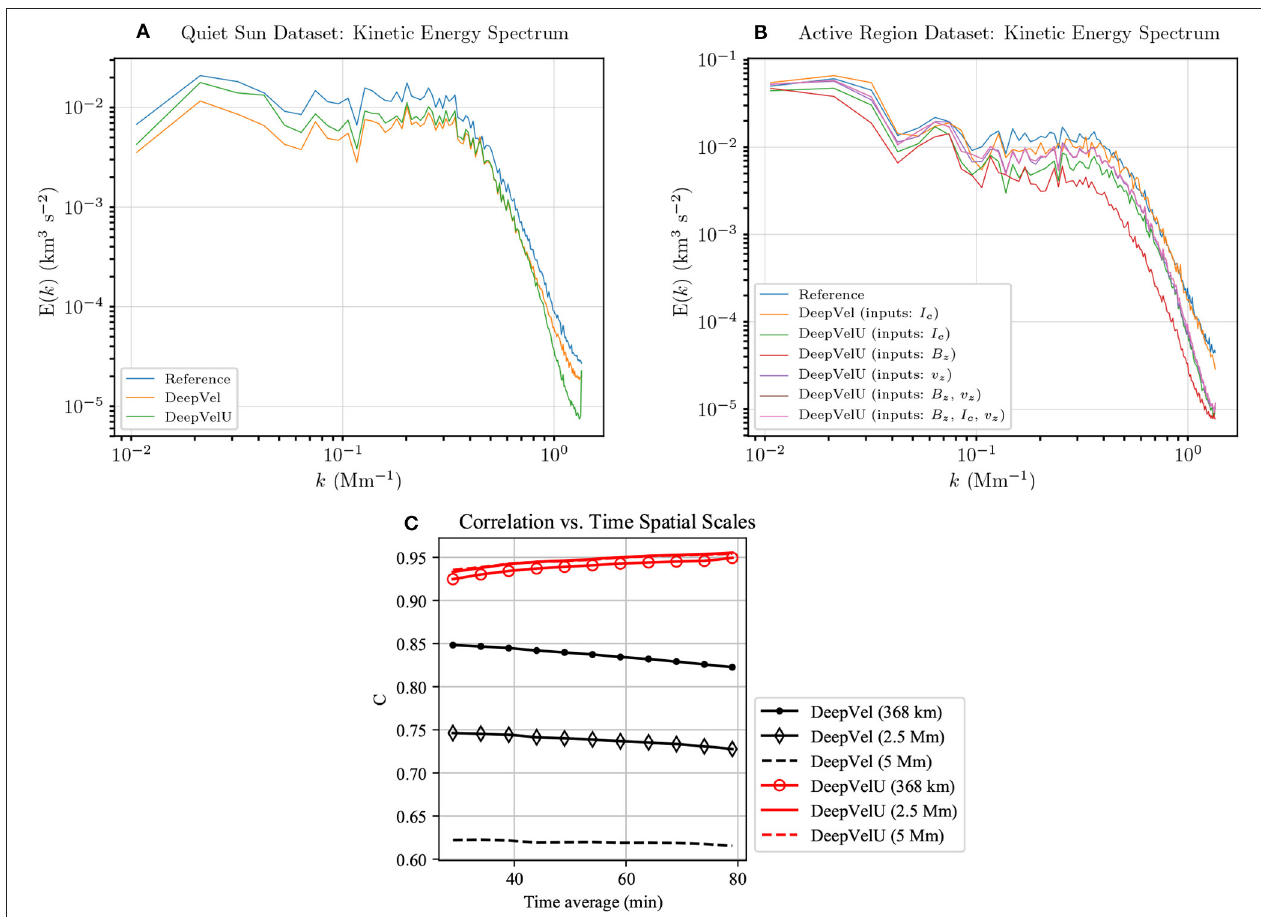
FIGURE 2 | Power spectra of the total kinetic energy E( k ) of the 30-timestep averaged transverse velocities as a function of the wavenumber k . (A) QS dataset. (B) ARs dataset. (C) Pearson correlation between the simulated transverse velocity field in the QS as a function of time and spatial averaging windows. The latter is shown with the full width at half maximum of the Gaussian kernel